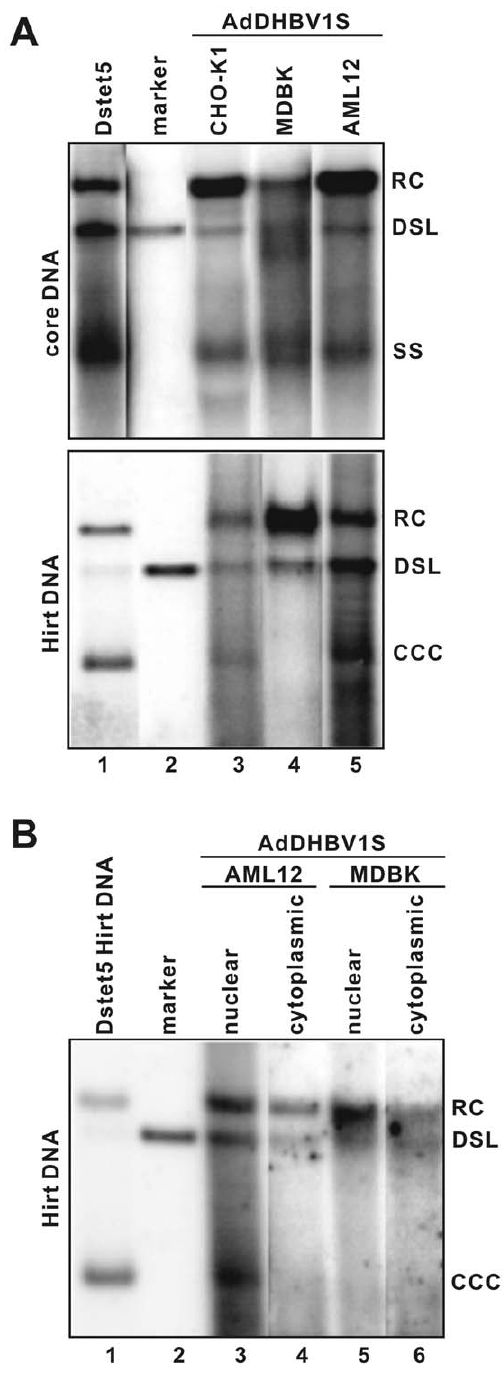
Figure 6. Subcellular distribution of the DP-DNA in MDBK and NCI-H322M cells. ( A ) AML12 and MDBK were infected with AdDHBV1S at a MOI of 10. On day 5 post infection, DHBV core- associated (upper panel) and Hirt DNA (lower panel) were extracted and analyzed by Southern blot hybridization. Hirt DNA prepared from the cytoplasmic and nuclear fractions of AdDHBV1S-infecetd AML12 and MDBK cells (B) or NCI-H322M cells (C) were analyzed by Southern blot hybridization assay. Core or Hirt DNA extracted from dstet5 cells cultured in the absence of tetracycline for 8 days (lane 1) and unit length of linear DHBV DNA (lane 2) served as controls.